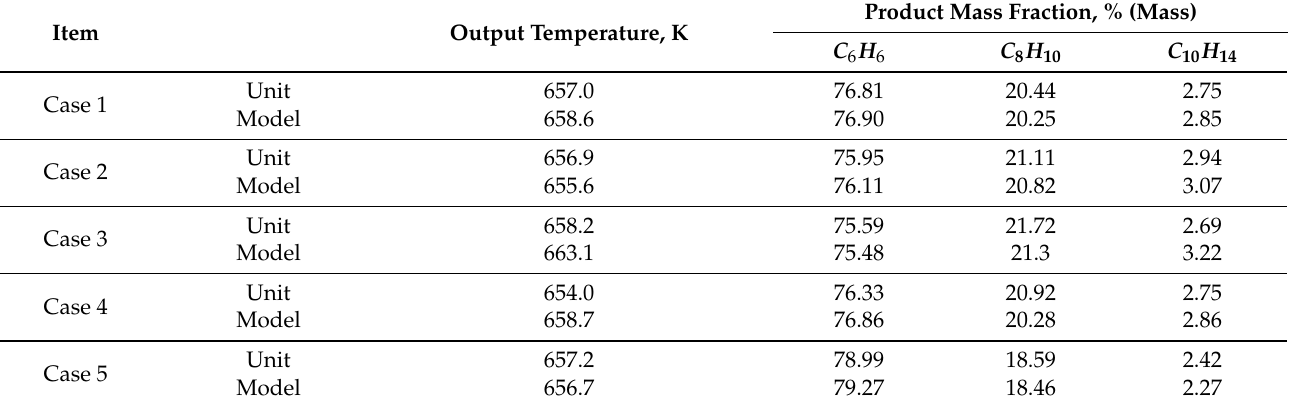
Table 4. Reactor model test